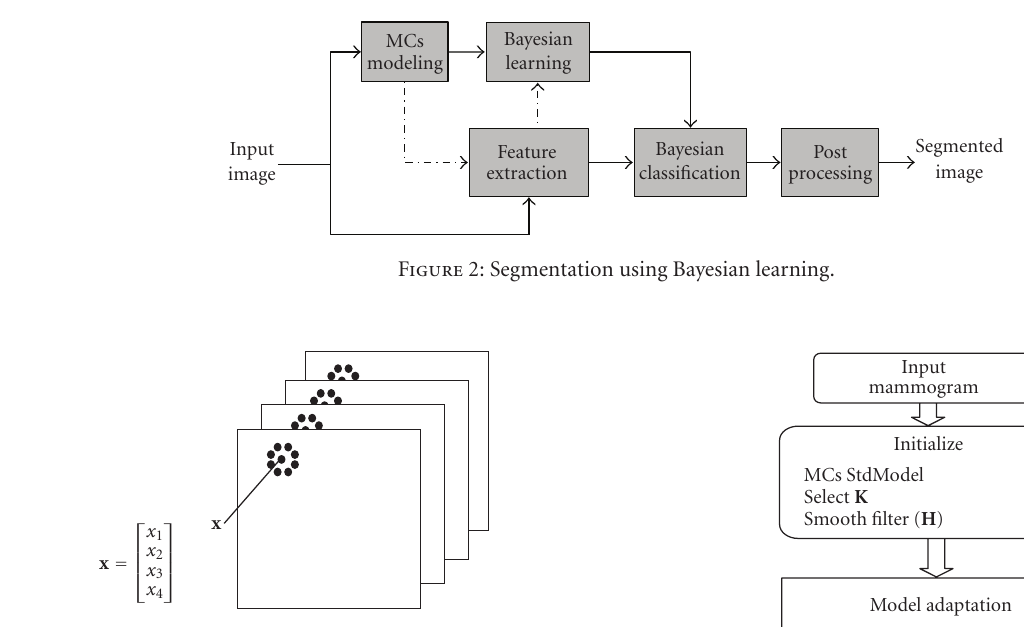
Figure 3: Composition of a pattern vector x using a four-image stack.